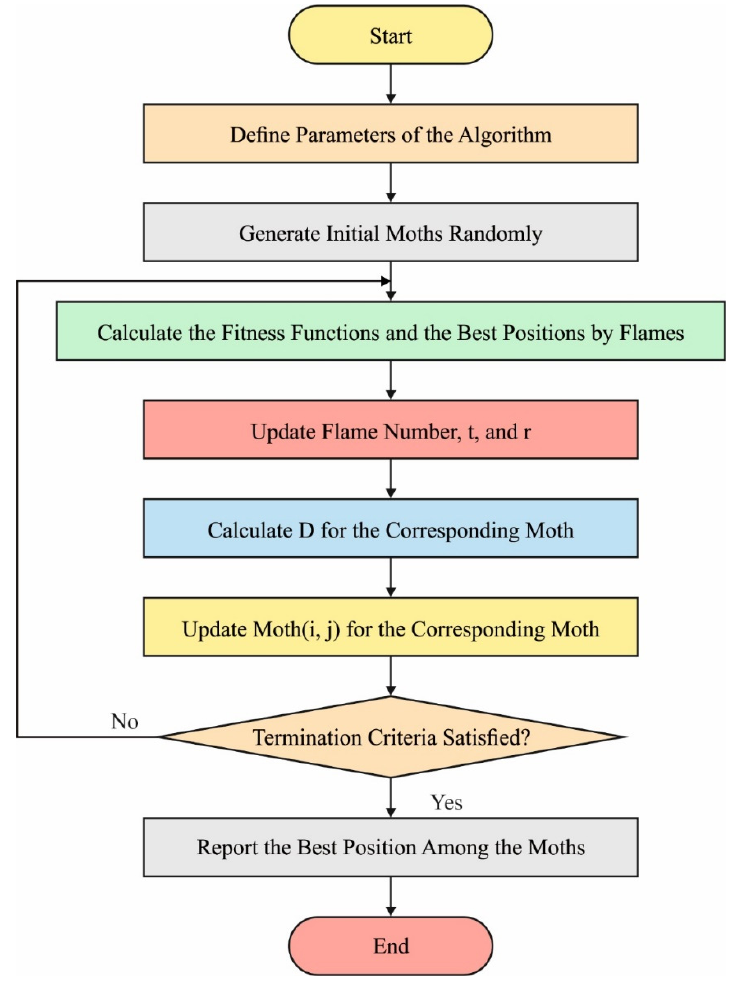
Figure 3. The Flowchart of MSO algorithm.